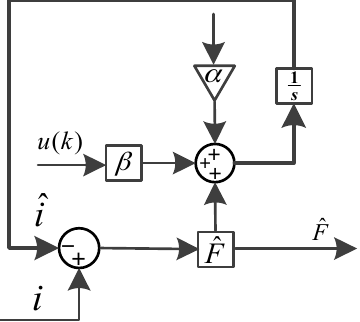
Figure 3. Block diagram of solving unknown quantity ˆ F .